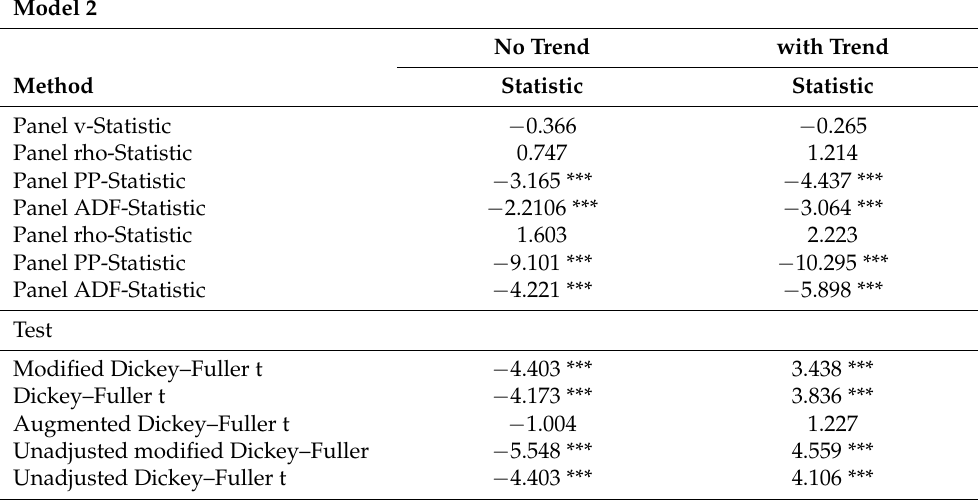
Table 9. Panel cointegration tests. Pedroni panel cointegration test and Kao Residual Cointegration for model